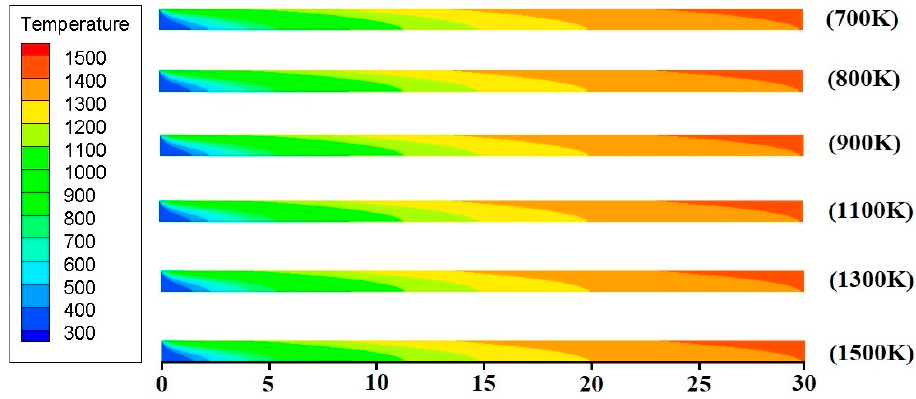
Figure 10. Distribution of exhaust gas temperature with different ignition temperatures.